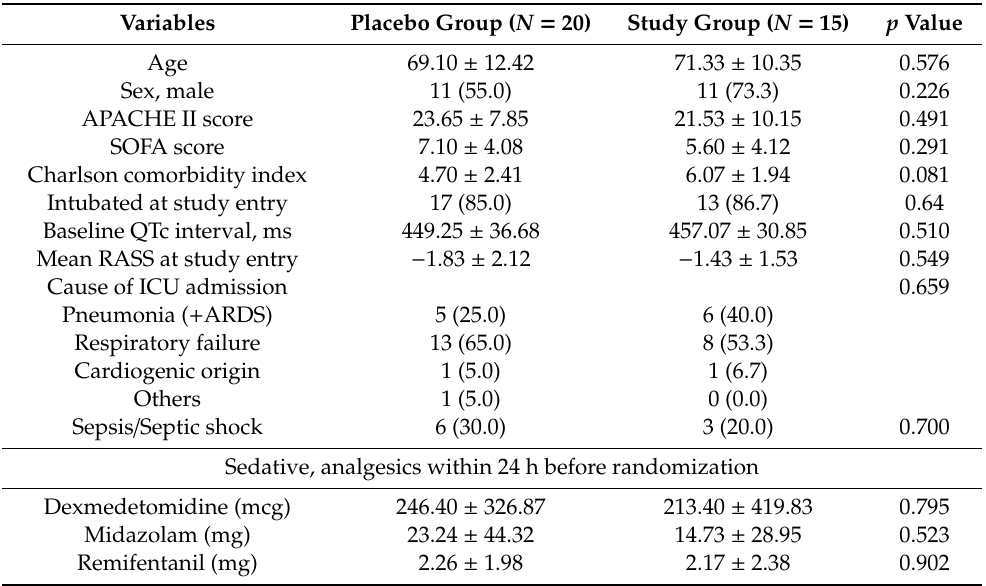
Table 1. Baseline characteristics of enrolled